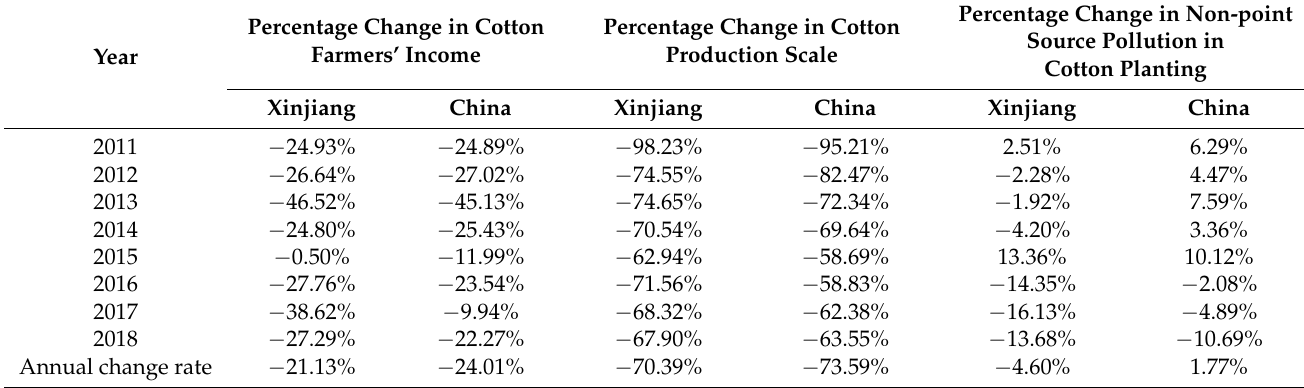
Table 6. Changes in effects of cotton subsidies in China and Xinjiang under the WTO